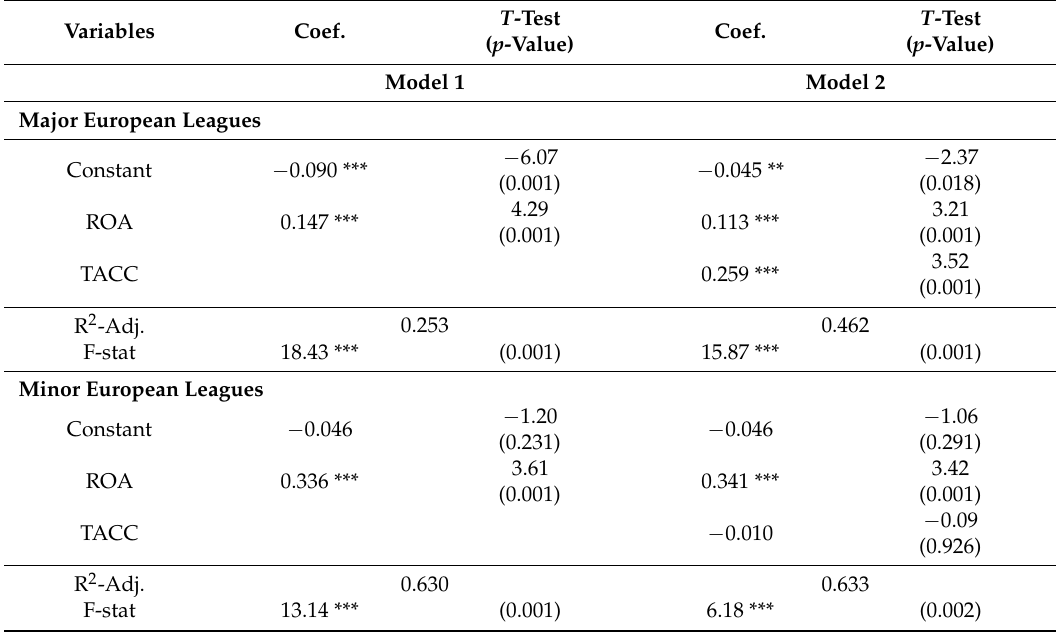
Table 6. Results of the persistence of accruals and cash flows between major and minor European leagues and during the pre and post FFP periods. (A) Panel A: Overall estimation between major and minor leagues; (B) Panel B: Results between major and minor leagues during the pre and post FFP periods. Panel A: Overall estimation between major and minor leagues.